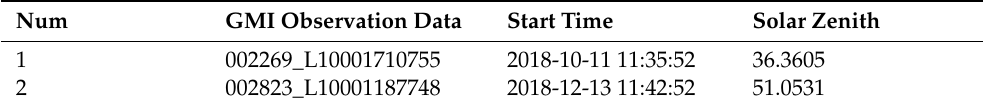
Table 3. Data information of GMI observation points at Kufra, Libya site. Num GMI Observation